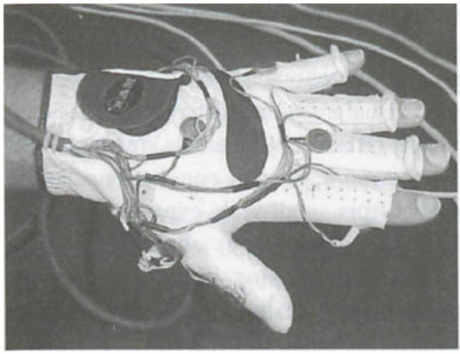
Figure 8. Tactile glove [90].